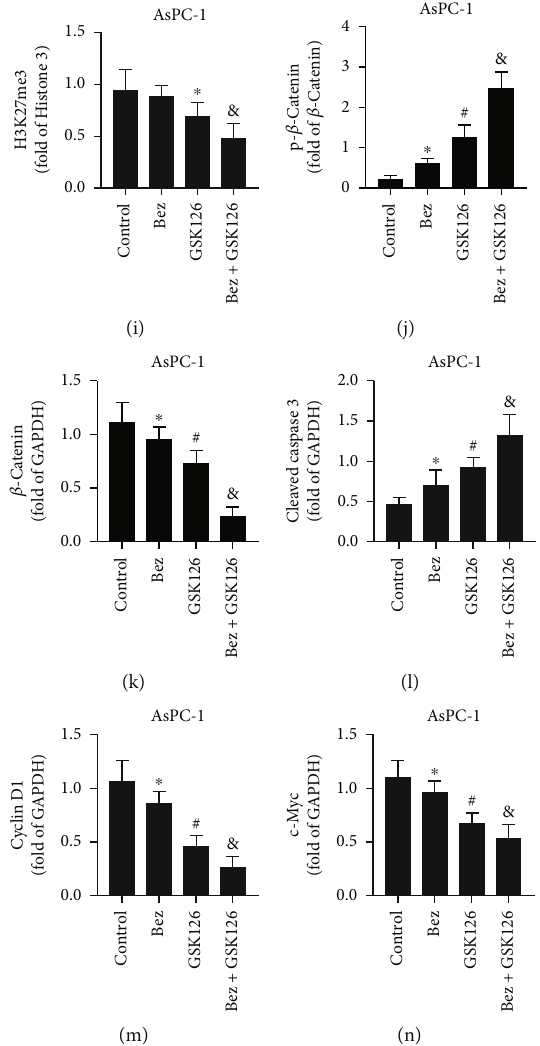
Figure 6: E ff ects of combination of beza fi brate and GSK126 on protein expressions in bearing tumors of CDXs. (a) Representative bands of western blot of H3K27me3, p- β -catenin, β -catenin, and cleaved caspase 3 in bearing tumors of PANC-1 CDX. (b) Representative bands of western blot of H3K27me3, p- β -catenin, β -catenin, and cleaved caspase 3 in bearing tumors of AsPC-1 CDX. (c) The relative band intensity of H3K27me3 in each experimental group of PANC-1 CDX. (d) The relative band intensity of p- β -catenin in each experimental group of PANC-1 CDX. (e) The relative band intensity of β -catenin in each experimental group of PANC-1 CDX. (f) The relative band intensity of cleaved caspase 3 in each experimental group of PANC-1 CDX. (g) The relative band intensity of cyclin D1 in each experimental group of PANC-1 CDX. (h) The relative band intensity of c-Myc in each experimental group of PANC-1 CDX. (i) The relative band intensity of H3K27me3 in each experimental group of AsPC-1 CDX. (j) The relative band intensity of p- β -catenin in each experimental group of AsPC-1 CDX. (k) The relative band intensity of β -catenin in each experimental group of AsPC-1 CDX. (l) The relative band intensity of cleaved caspase 3 in each experimental group of AsPC-1 CDX. (m) The relative band intensity of cyclin D1 in each experimental group of AsPC-1 CDX. (n) The relative band intensity of c-Myc in each experimental group of AsPC-1 CDX. The values were expressed as the means ± S : E : M : ( n = 6 for each group). ∗ P < 0 : 05 vs. the control group, # P < 0 : 05 vs. the Bez group, and & P < 0 : 05 vs. the GSK126